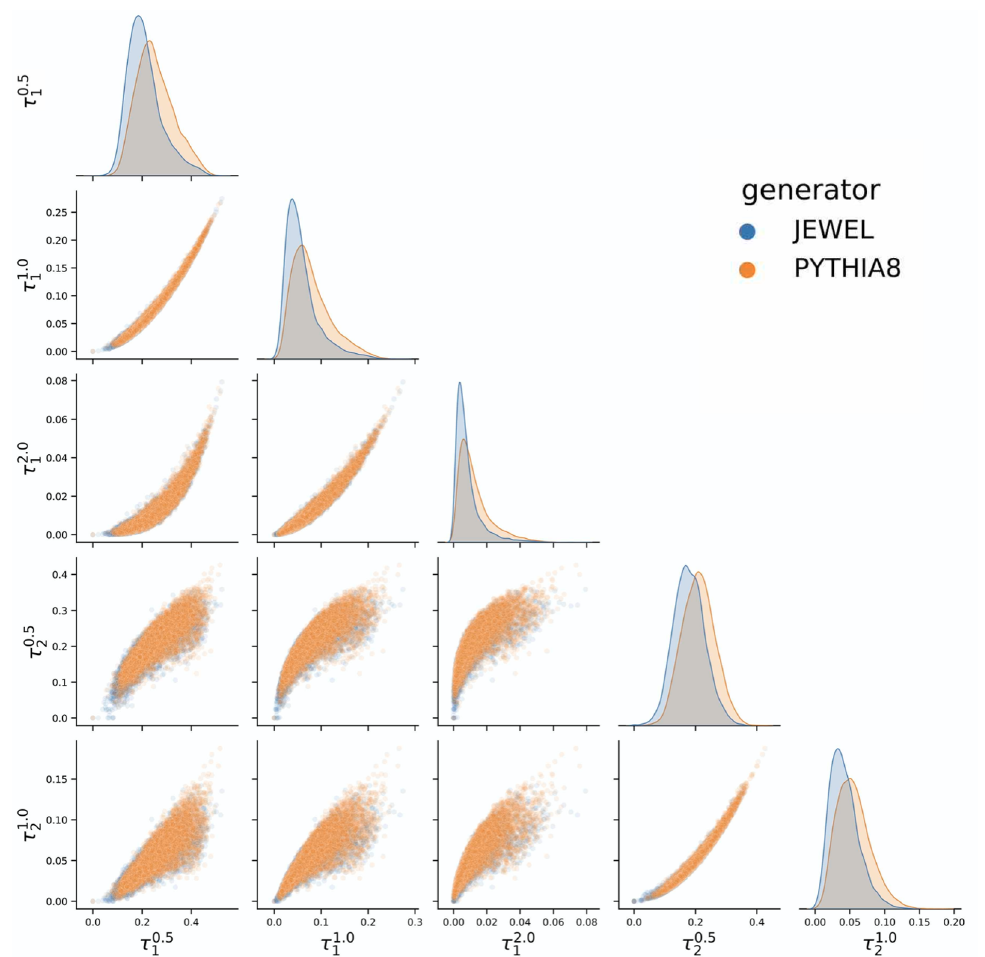
Figure 3 . Scatter plot showing different N -subjettiness distributions (diagonal) and their pairwise correlations (off-diagonal panels) in pp and AA collisions without background. The pp and AA results shown here are obtained from Pythia 8 [70] and Jewel [72, 73],